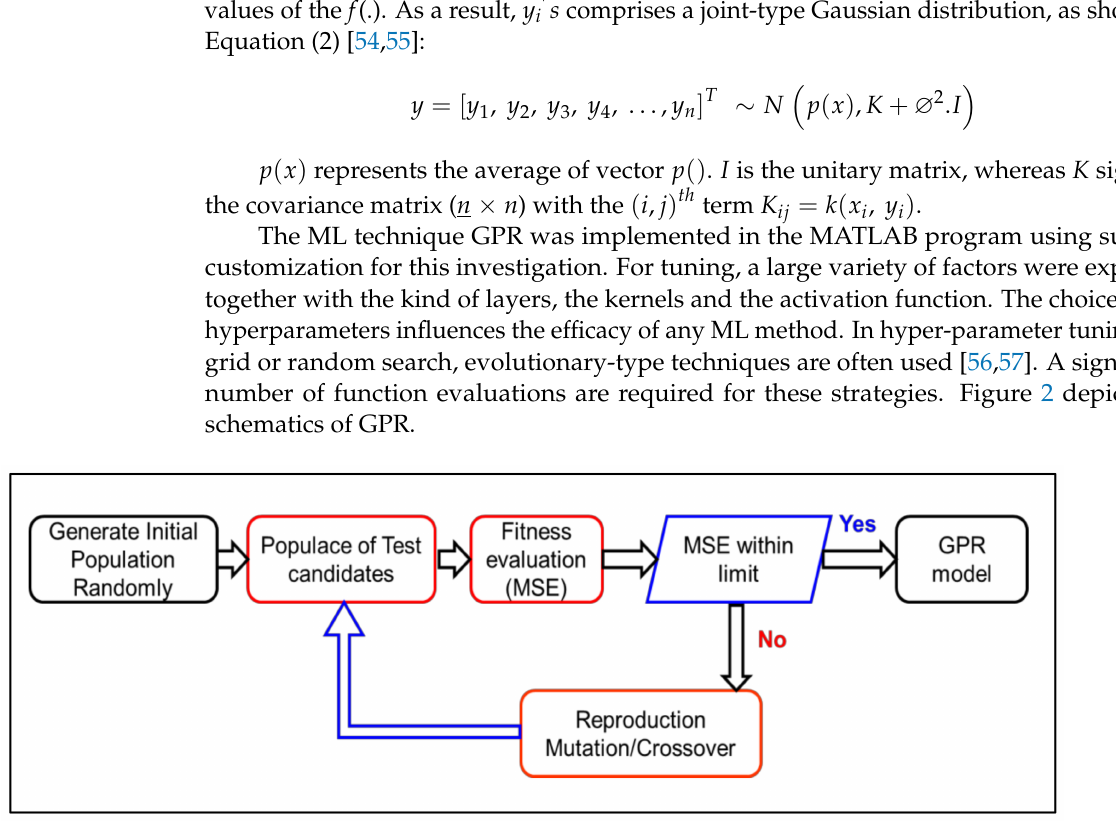
Figure 2. Schematics of